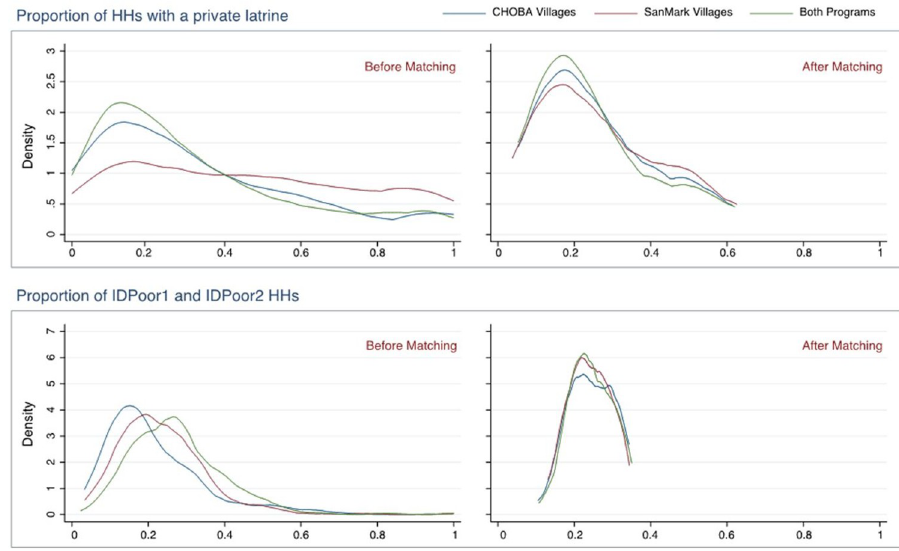
Fig 3. Frequency distributions of latrine coverage and poverty pre- and